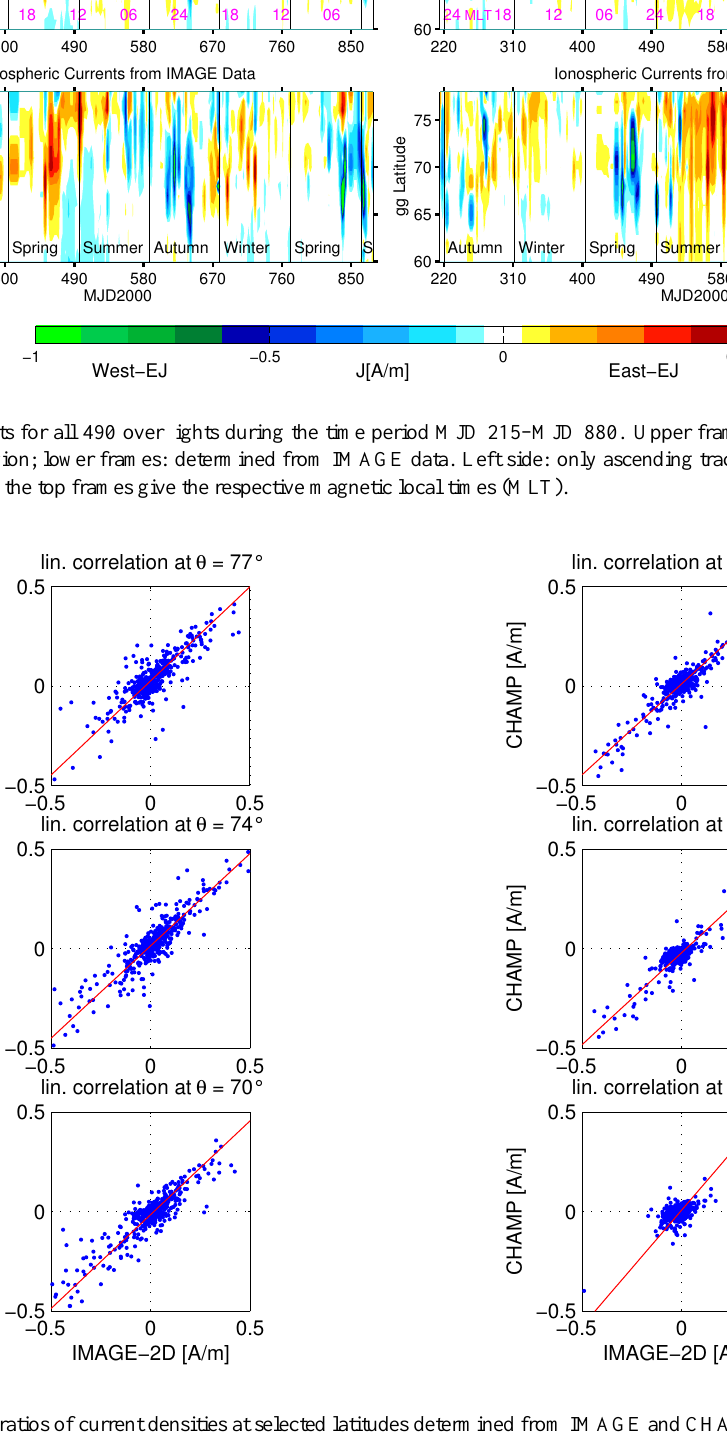
lation drops off in the region south of the electrojet. The third graph shows a similar picture, the amplitude ratio IMAGE to CHAMP stays close to one in the region of high current den- sity. The average value for the ratio between θ = 63 ◦ ... 70 ◦ N is 1.08 ± 0.01. The offset of the regression lines (in- tercept), as shown in the bottom panel, may either be caused